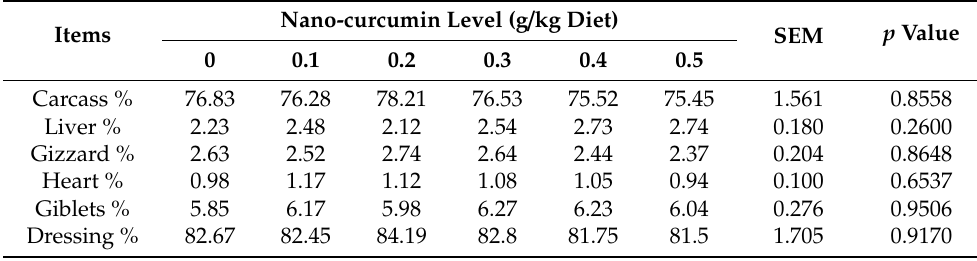
Table 4. Carcass traits and relative organs of growing Japanese quail as a ff ected by dietary